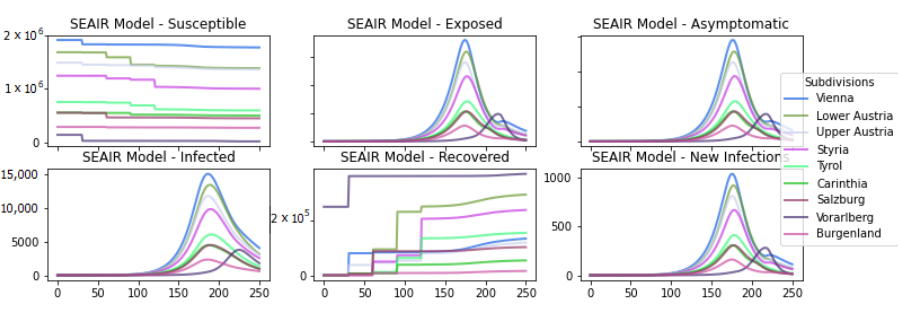
Figure 8. Plots of susceptible, exposed, asymptomatic, infected, recovered, and newly infected individuals per day for each region of the SEAIR model with the best vaccination plan found. Table 8. Comparison table of infections with and without vaccination. With Without Decrease Best Vaccination Percentage